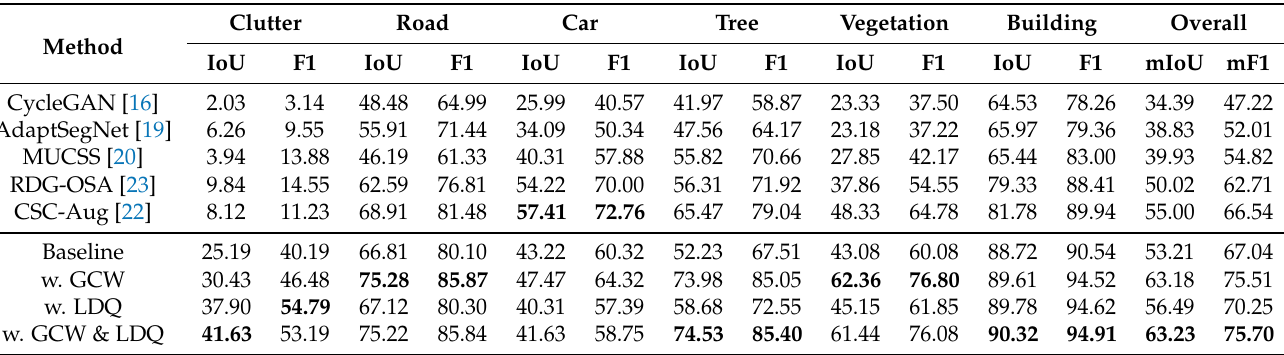
Table 1. Quantitative results (%) on POT → VAI.